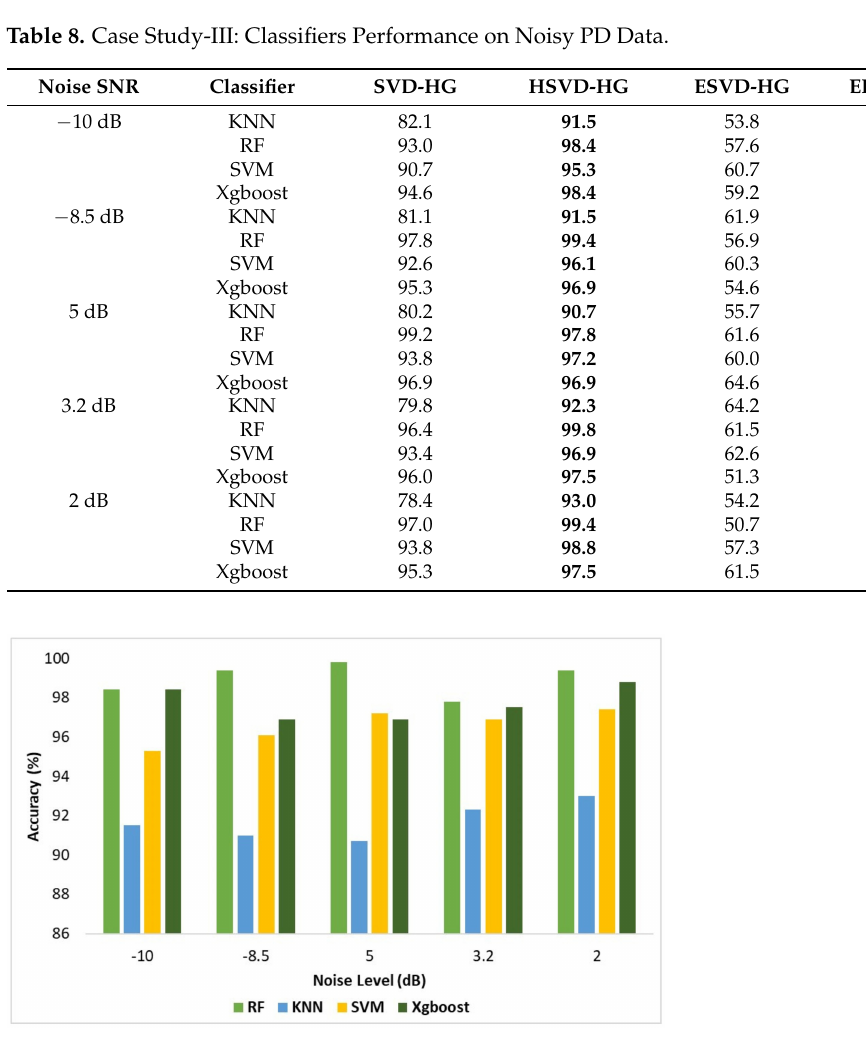
Figure 8. Accuracy comparison plot for different noise level for HSVD-HG